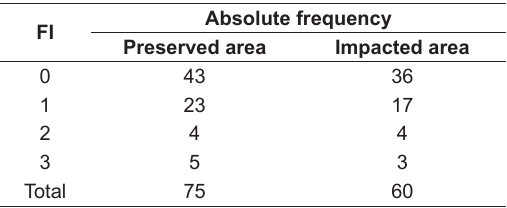
Table 1. Absolute frequency of Fullness Index (FI) class for gut content of P. squamosissimus